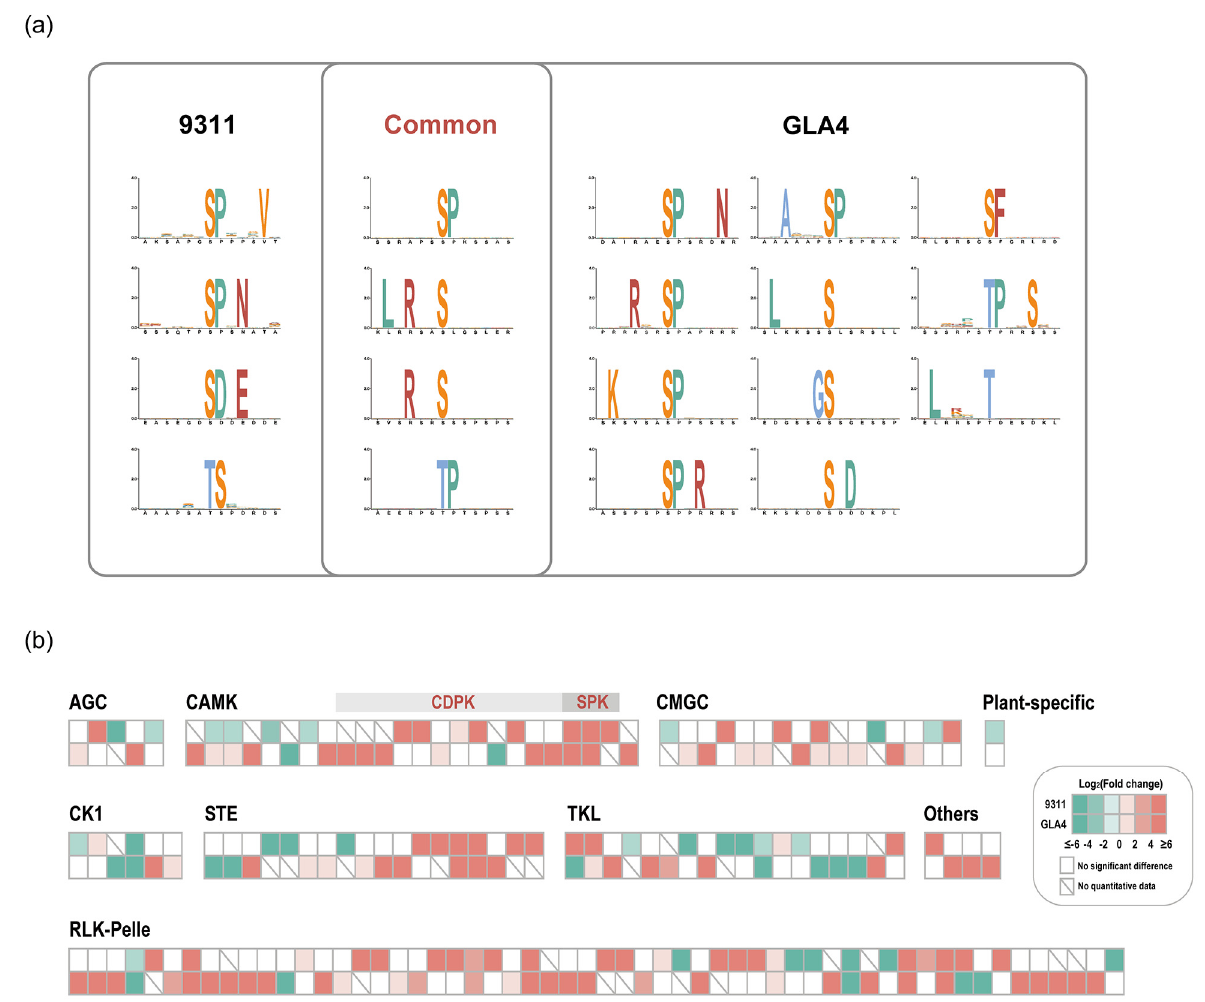
Figure 4. Motif enrichment analysis of differential phosphopeptides in 9311 and GLA4 ( a ) and phosphorylated kinases with significant differences in rice endosperm under high-temperature stress ( b ).